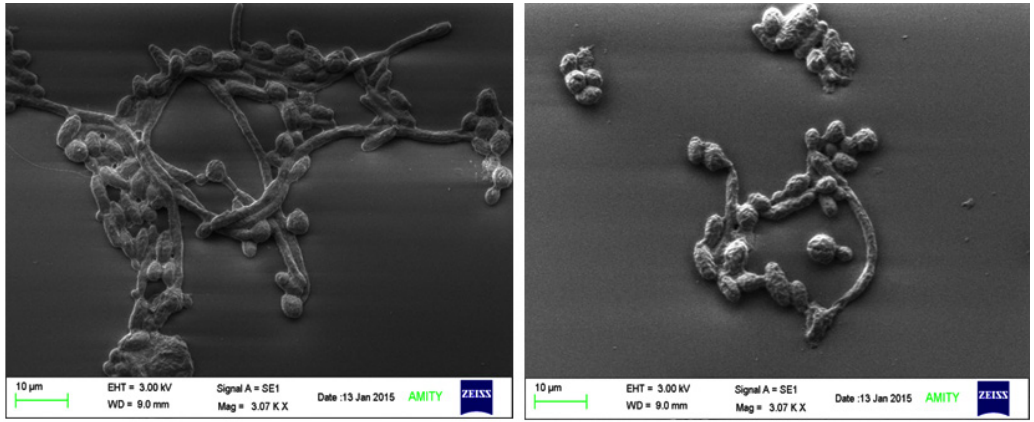
Fig. 9. Scanning electron micrographs of C. albicans ATCC 10261 biofilms grown for 24 h on silicon discs in the absence (A) and presence (B) of geraniol at MIC. In the absence of geraniol a dense population of yeast cells and hyphae could be seen while in the presence, a loss in the biofilm structural elements could be